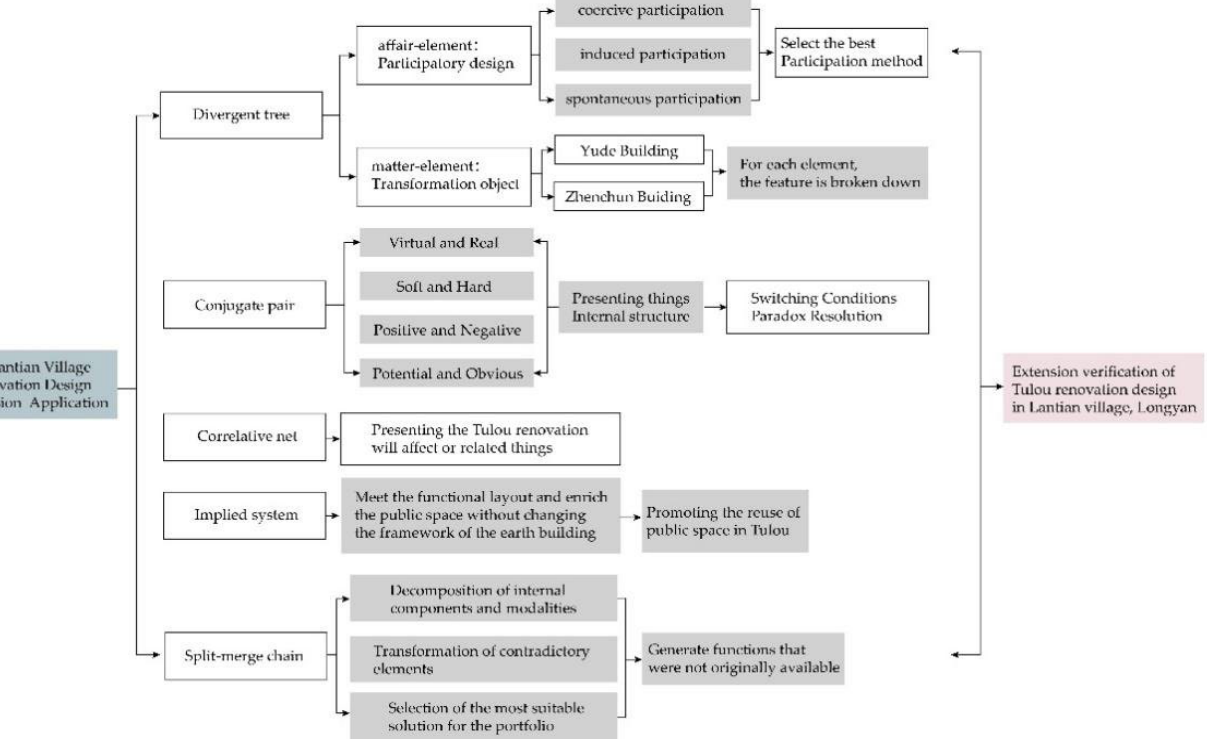
Figure 7. The technical framework.